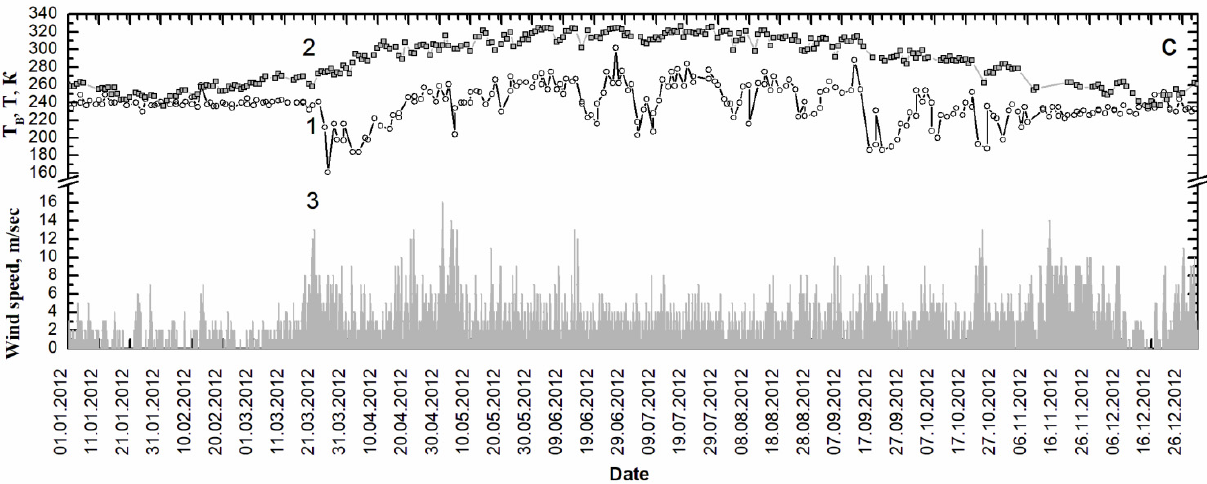
Figure 6. Seasonal dynamics of T BH , T and meteorological parameters: ( a ) snow cover, ( b ) rainfall, ( c ) wind velocity, 1—brightness temperature T BH , 2—temperature T, 3—meteorological parameters (H snow in ( a ), Precipitation in ( b ), and Wind speed in ( c )), 4—periods without precipitation, 5—period of drought which ended with the declaration of a state of emergency.